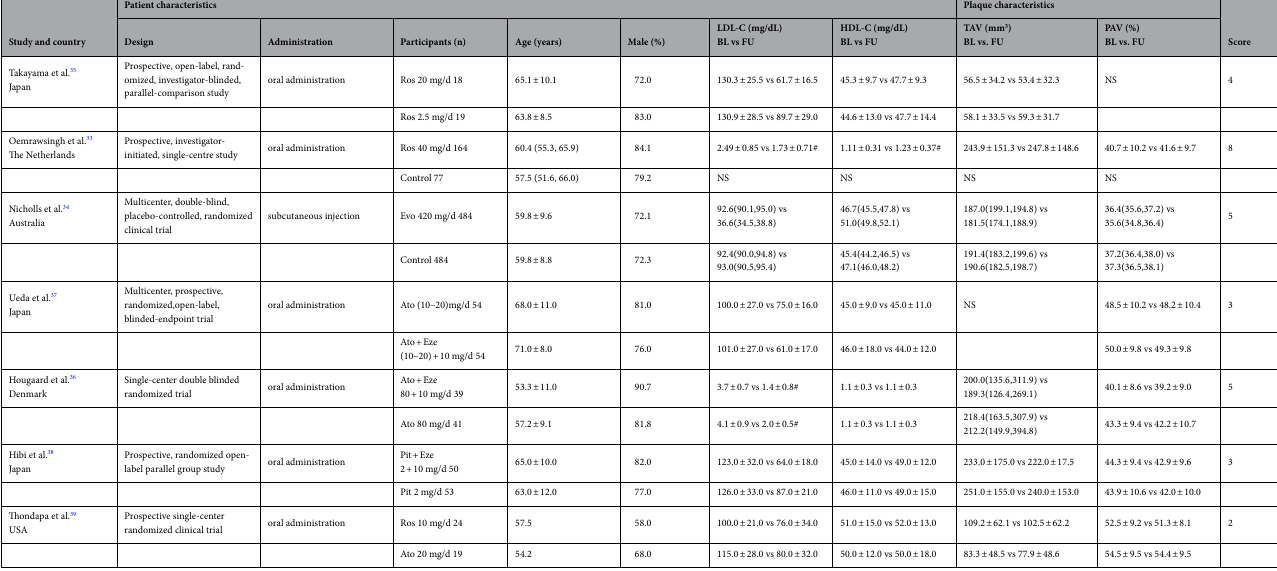
Table 1. Characteristics of included studies. LDL-C low-density lipoprotein cholesterol, HDL-C high–density lipoprotein cholesterol, TAV total atheroma volume, PAV percentage atheroma volume, BL baseline, FU follow-up, Ato atorvastatin, Ros rosuvastatin, Pra pravastatin, Pit pitavastatin, Sim simvastatin, Flu fluvaststin, Eze ezetimibe, Evo evolocumab, # the value was provided as mmol/l; *the value was provided as volume index defined as the volume divided by the segment length (mm 3 /mm).